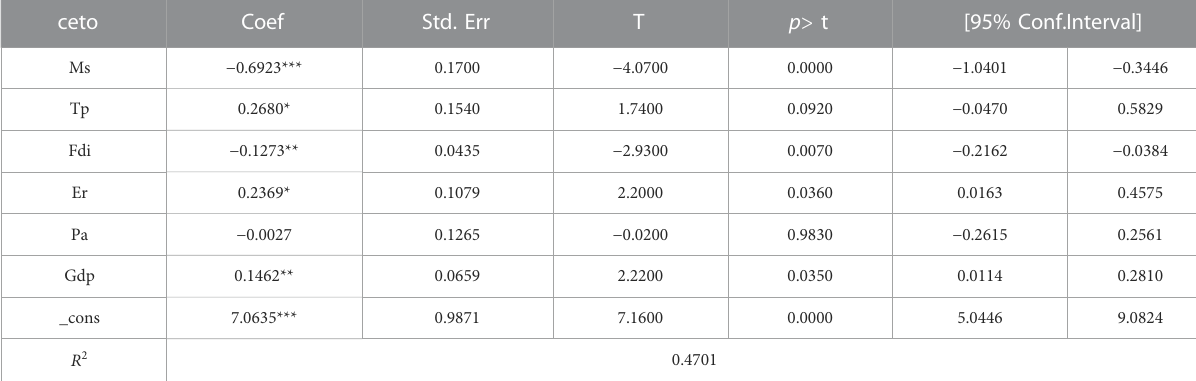
TABLE 3 Mixed estimation of industrial structure optimization, population agglomeration and carbon